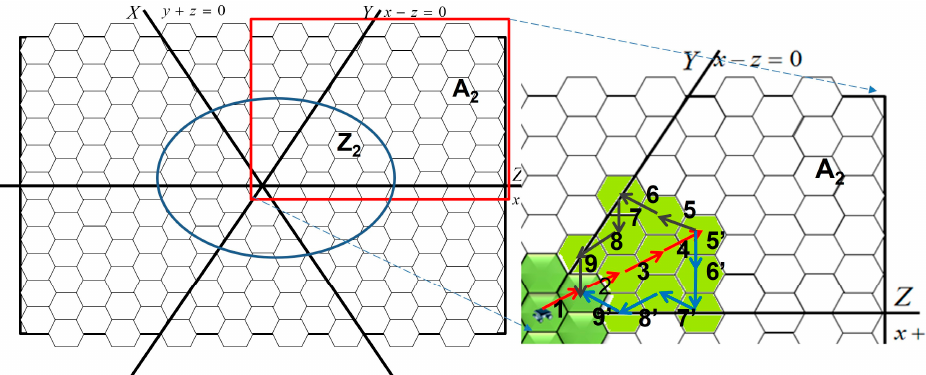
Figure 5. Moving paths in the movement region Z 2 . The numbers represent the steps of sensors. The sensors move in the path iteratively. For example, one sensor moves in path 1->2->3->4->5->6->7->8->9, and its following sensor should move in path 1->2->3->4->5’->6’->7’->8’->9’. The brighter green cells represent the charging zone,